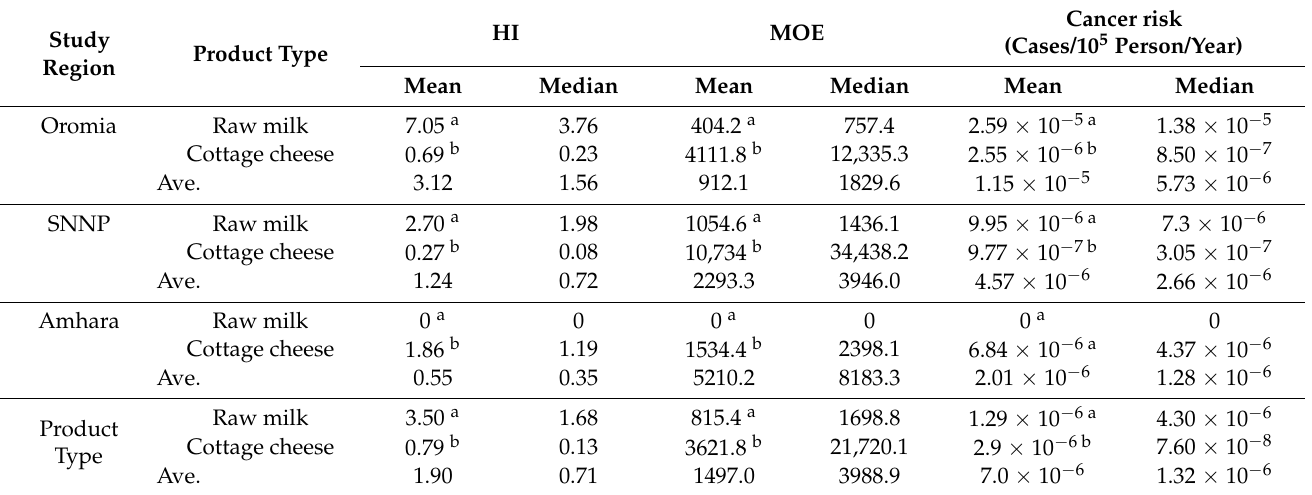
Table 3. Risk characterization of AFM 1 through intake of raw milk and cottage cheese in the three regions of